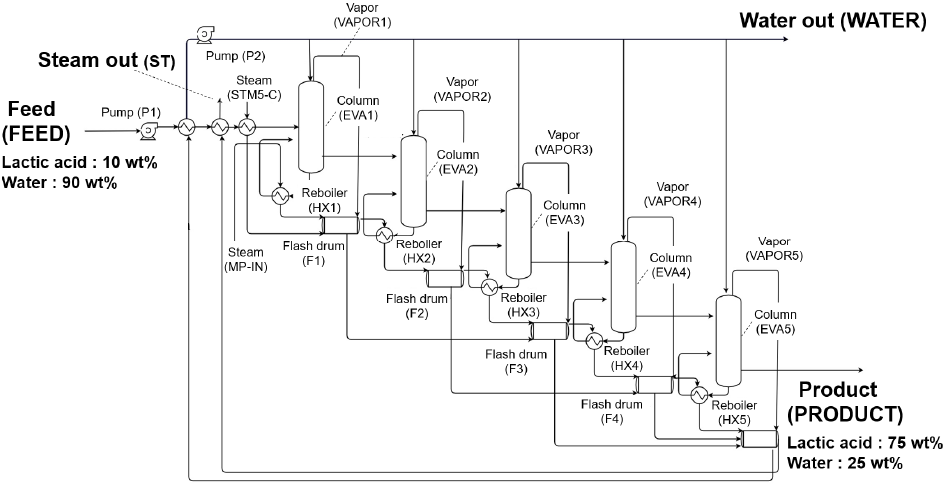
Figure 2. Simplified diagram of alternative evaporation process model using MEE. Table 2. Specification of alternative process model using MEE.